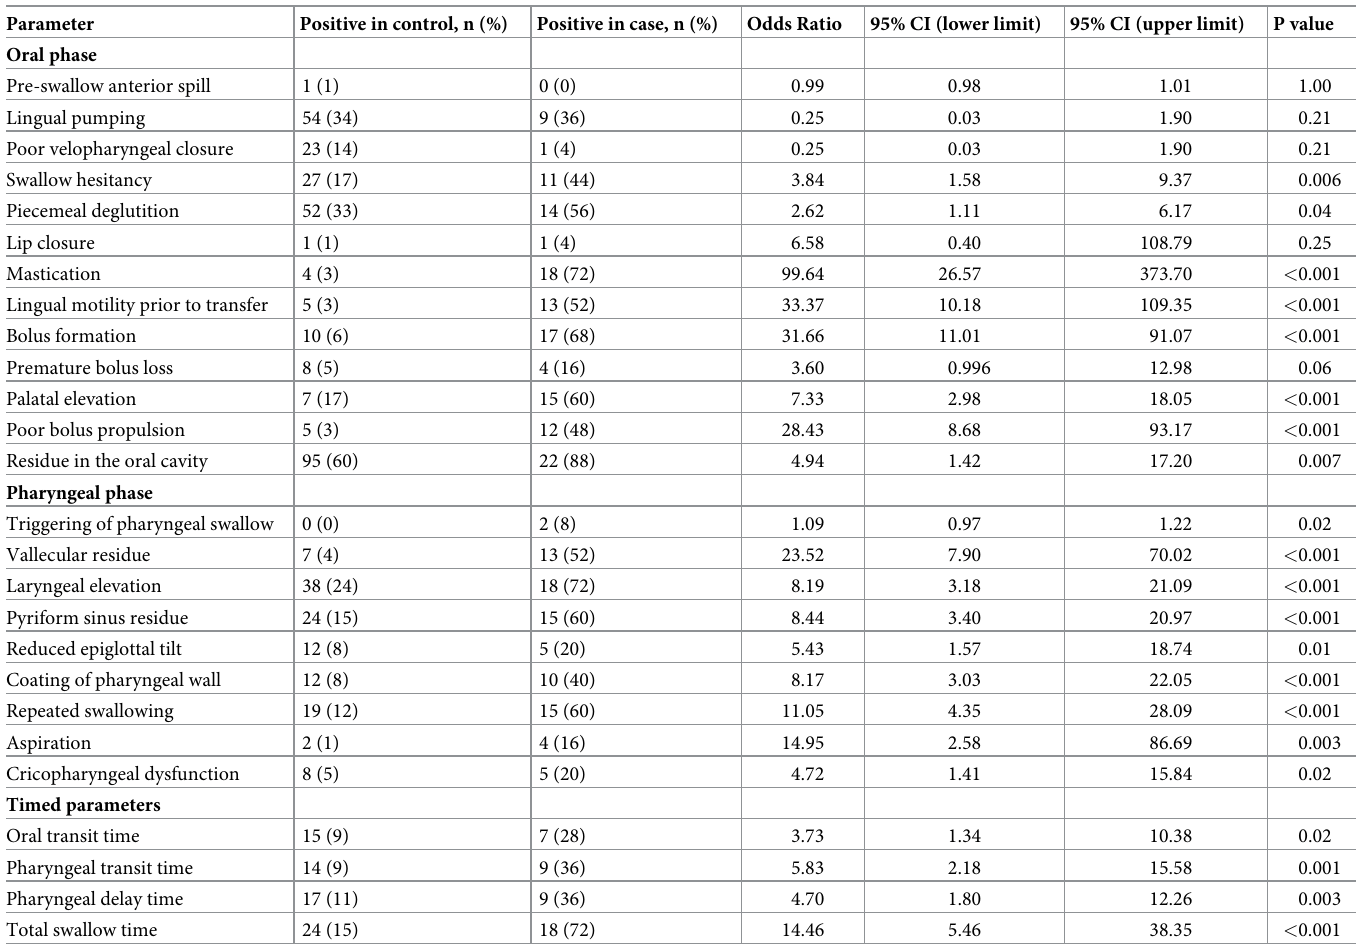
Table 2. Crude odds ratio of each VFSS parameter for the development of aspiration pneumonia.